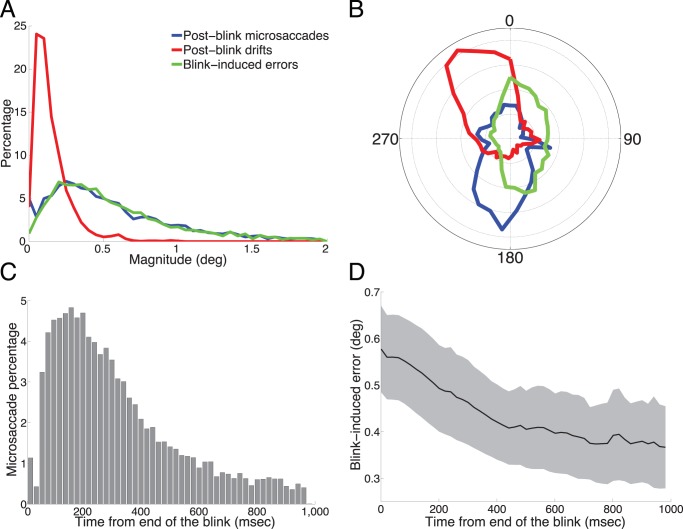
Blink-induced error and microsaccade properties.(A) Normalized magnitude distributions of blink-induced fixation errors, post-blink microsaccades, and post-blink drifts across non-human primates. The distribution of post-blink microsaccade magnitudes matches closely that of blink-induced fixation errors. (B) Polar histogram of the directions of blink-induced fixation errors, post-blink microsaccades, and post-blink drifts. Blink-induced fixation errors are more likely directed upward. Post-blink microsaccades tend to move the eye downward, thus counteracting the error introduced by the blink. (C) Latency distribution for post-blink microsaccades (all monkeys combined): 74.12% of post-blink microsaccade onsets occurred in the initial 400 msec after the end of the blink. (D) Blink-induced error as a function of time, from the end of the blink onward. We calculated the blink-induced error at every point in time, whether there were concurrent microsaccades or drifts. The blink-induced error declines gradually, showing the largest decrease in the initial 400 msec interval, simultaneous to the highest production of post-blink microsaccades. Shaded area indicates the SEM across monkeys (n = 5 monkeys).